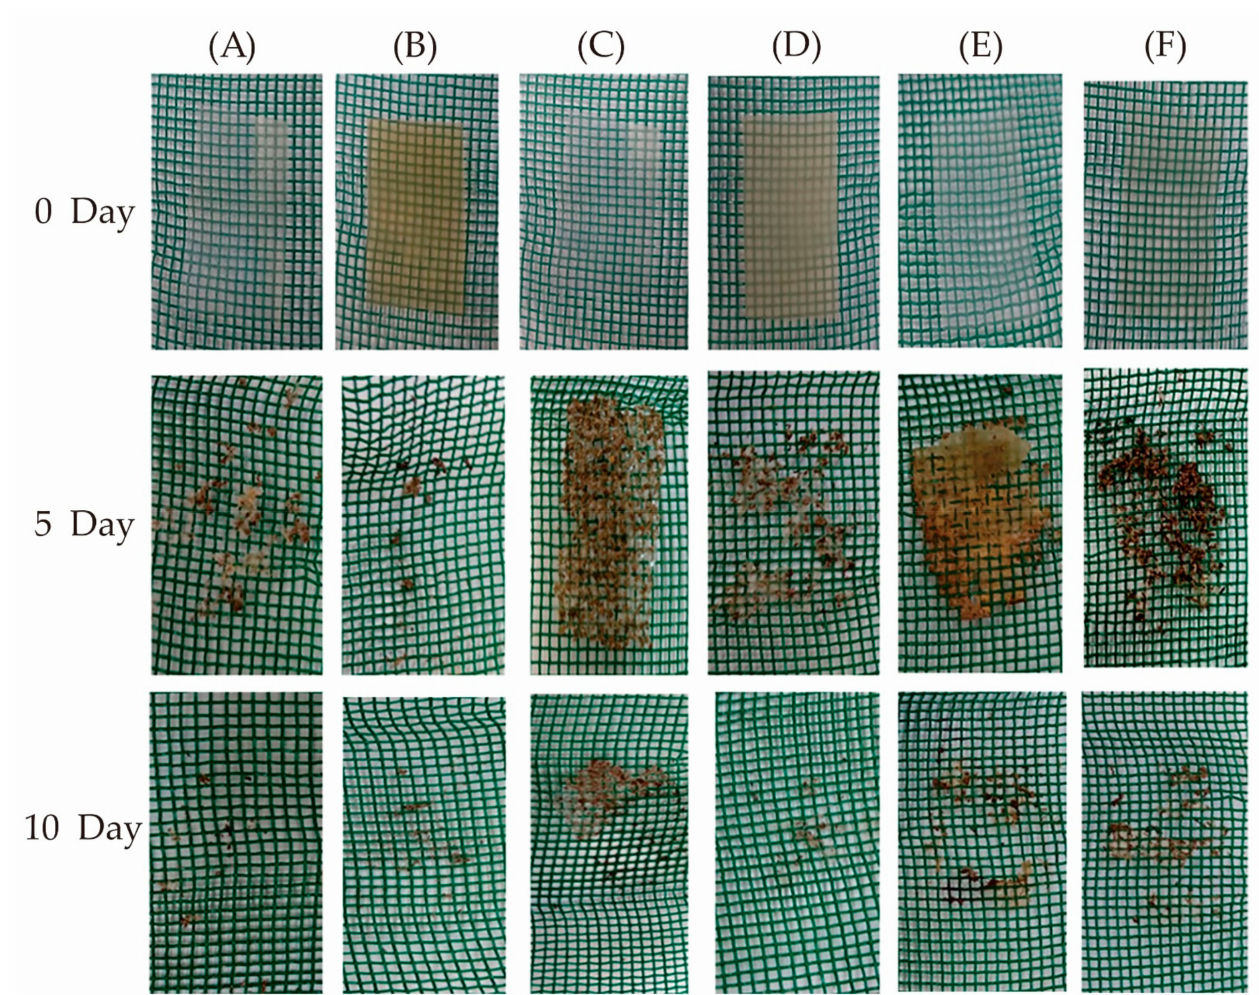
Figure 5. Biodegradability in the soil of different edible films. ( A ) Collagen film; ( B ) Whey protein film; ( C ) Methylcellulose film; ( D ) Collagen/whey protein blend film; ( E ) Collagen/methylcellulose blend film; ( F ) Whey protein/methylcellulose blend film. (Adapted with permission from Filipini [91]; published by John Wiley and Sons,